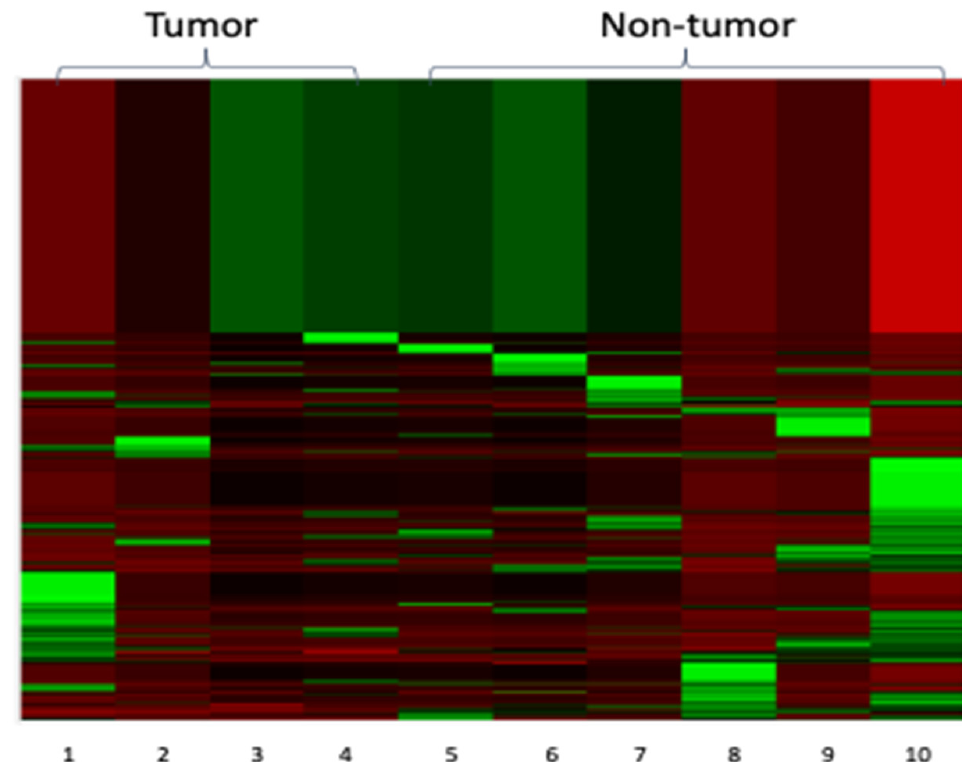
Figure 1. Heat map of all 724 cancer-related genes in the 10 MF patient samples. The NanoString nSolver Analysis Software used hierarchical clustering to group samples and genes together based on relatedness. Red shading indicates low gene expression relative to the average expression, black shading indicates average expression and green shading indicates high gene expression relative to the average expression. All 4 tumor MF samples were clustered on the left of the panel and all 6 non-tumor MF samples were clustered on the right of the panel.